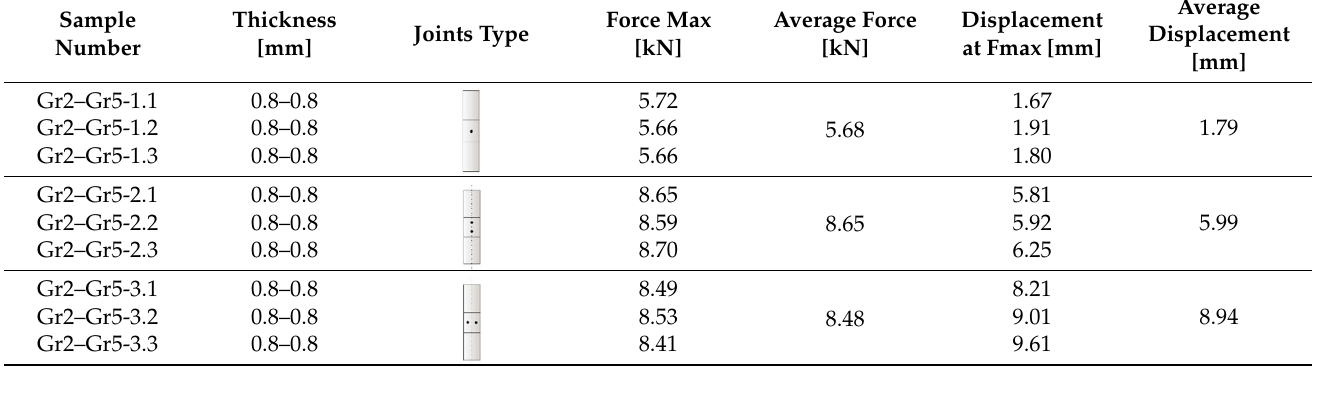
Table 6. Results from the tensile shear test of Gr2–Gr5 joints.